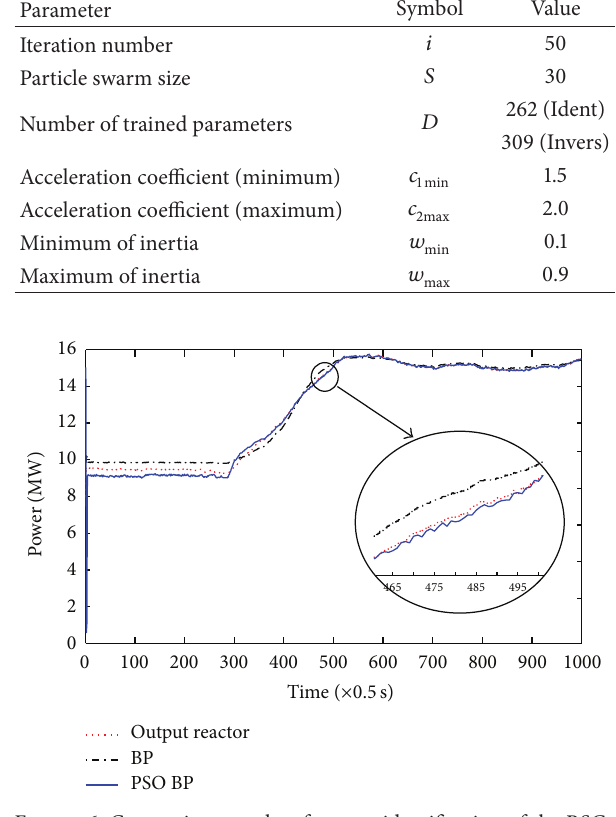
Figure 6: Comparison results of system identification of the RSG- GAS using backpropagation and hybrid